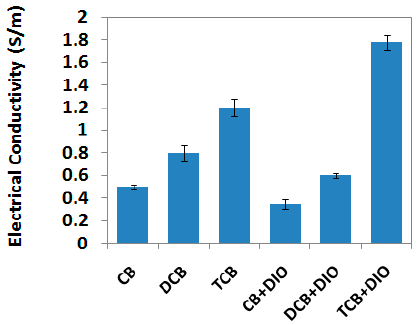
Figure 3. Electrical conductivity values of PTB7 samples prepared from different solvents with and without DIO.